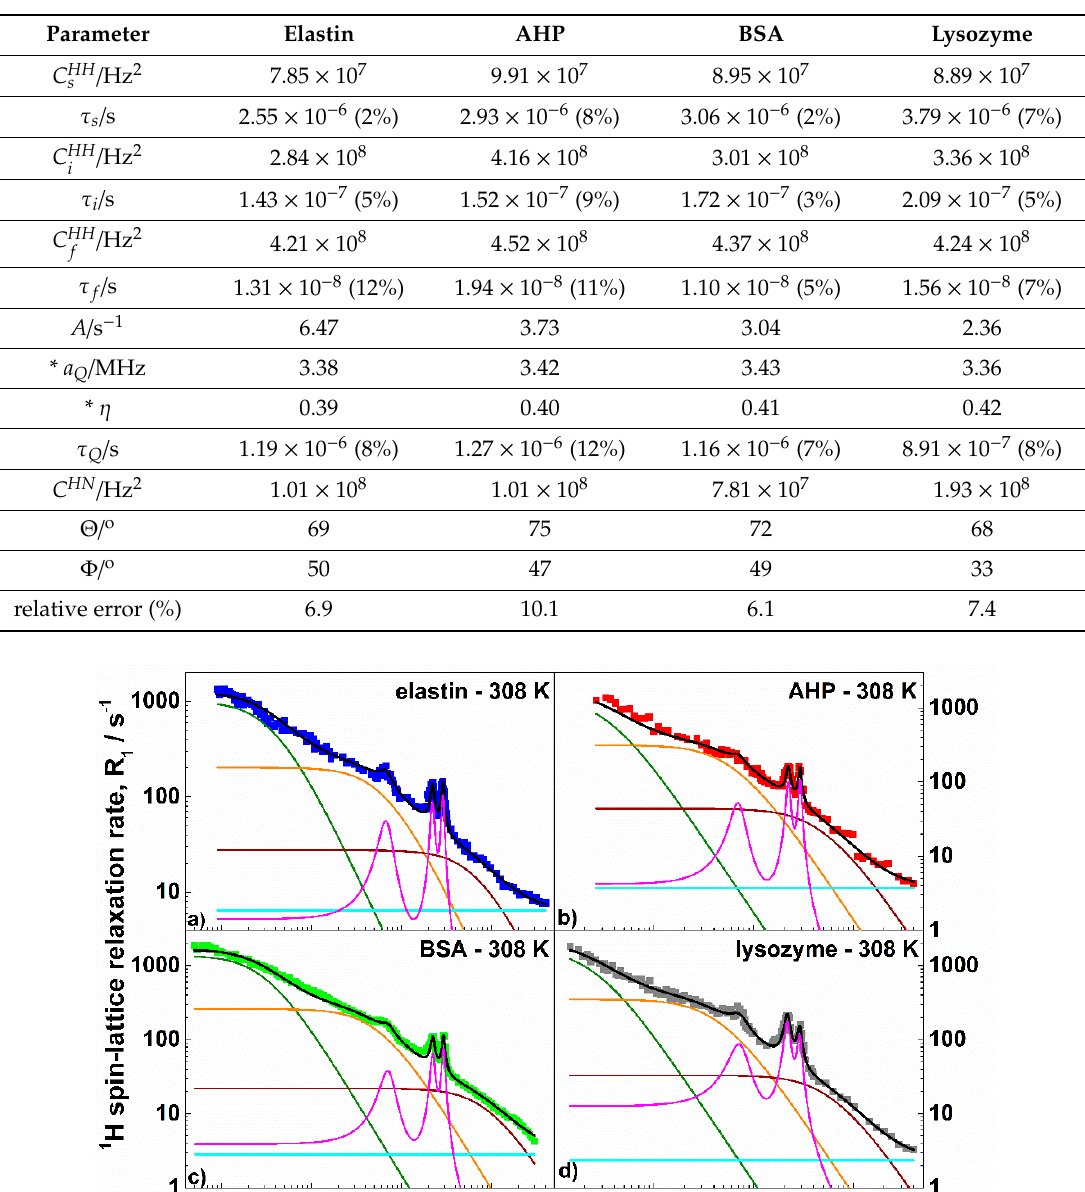
Table 1. Parameters obtained from the analysis of the 1 H spin–lattice relaxation data; * non-adjustable parameters. The uncertainty level of the correlation times is provided in the parentheses. For the relaxation constants, the level is in the range of 5–8%.